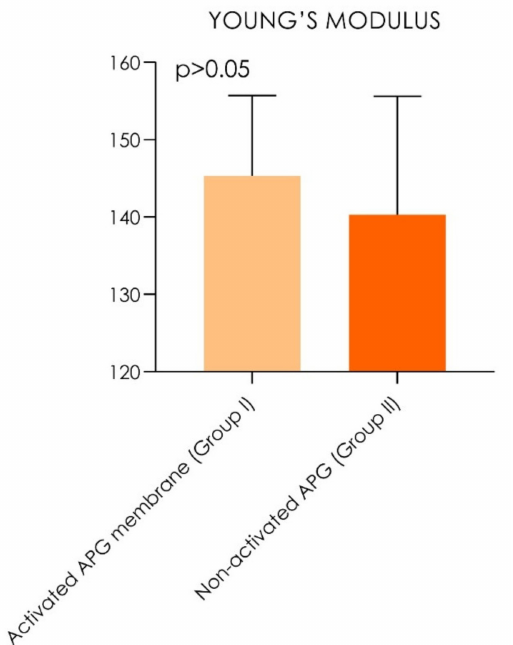
Figure 7. Graph chart of the Young’s modulus. No statistically significant difference was detected between the groups during comparison (Wilcoxon signed-rank test, p > 0.05).